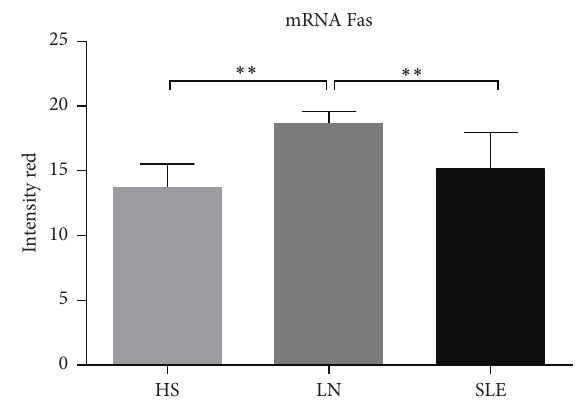
Figure 6: Expression the mRNA Fas receptor in renal tissue of SLE, LN patients, and HS. Difference between LN with other groups was significant. ∗∗ 𝑃 < 0.006